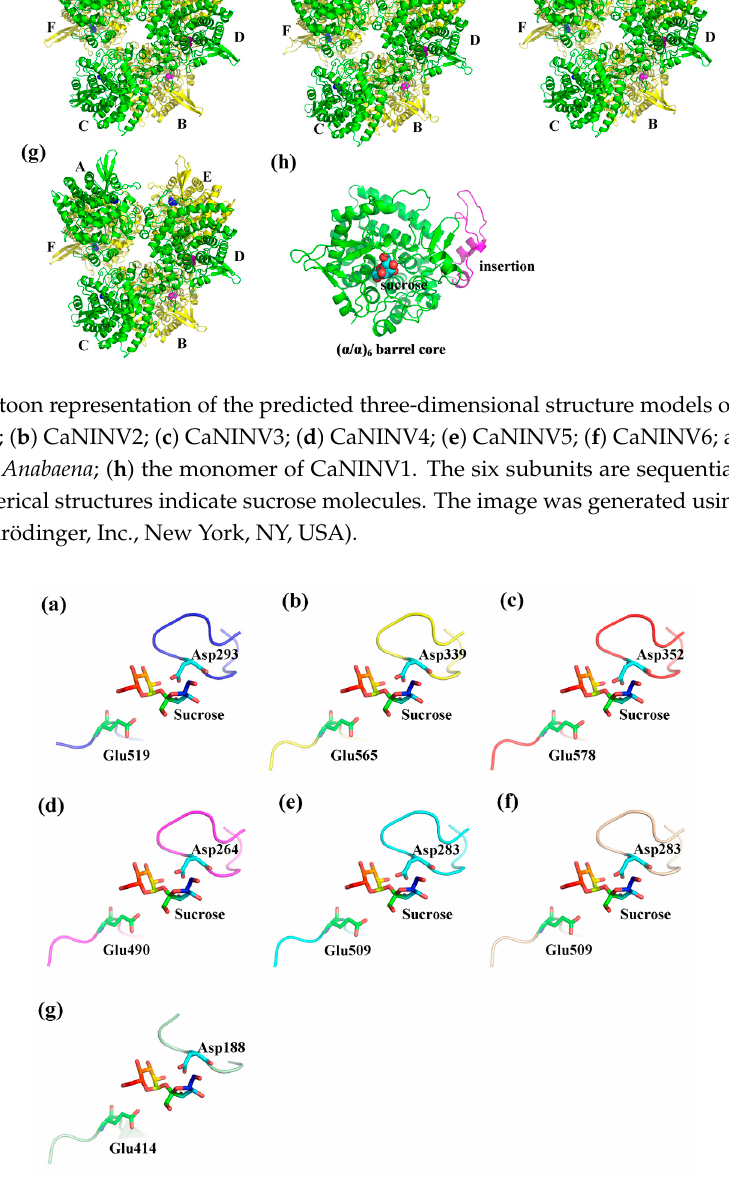
Figure 7. Predicted catalytic residues of CaNINV1–6 with sucrose molecules. ( a ) CaNINV1; ( b ) CaNINV2; ( c ) CaNINV3; ( d ) CaNINV4; ( e ) CaNINV5; ( f ) CaNINV6; ( g ) NINV protein from Anabaena (Protein Databank ID 5GOR). Colored stick structures indicate sucrose molecules. Green stick and blue stick structures represent the catalytic residues of Glu and Asp, respectively. The image was generated using the PyMOL program (Schrödinger, Inc., New York, NY, USA).